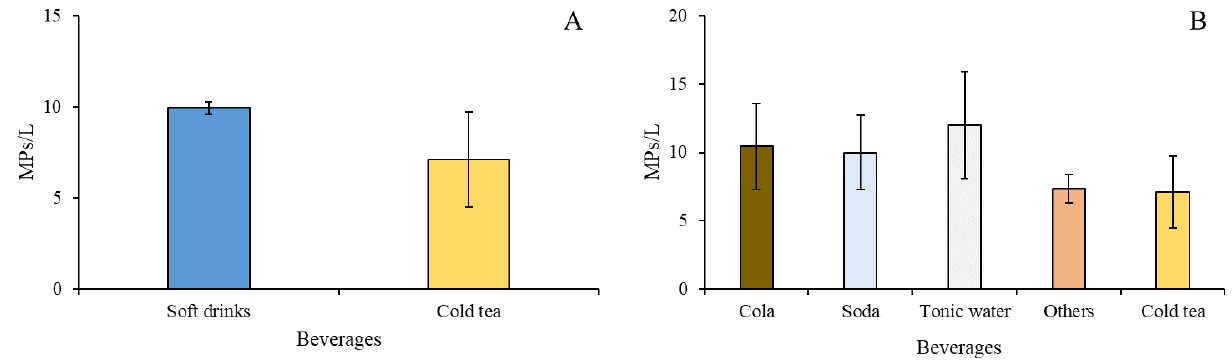
Figure 2. Mean concentration of MPs ( ± SEM) was measured in soft drink and cold tea samples ( A ) and in different groups of beverages ( B ). Three different brands of beverages per group were tested.